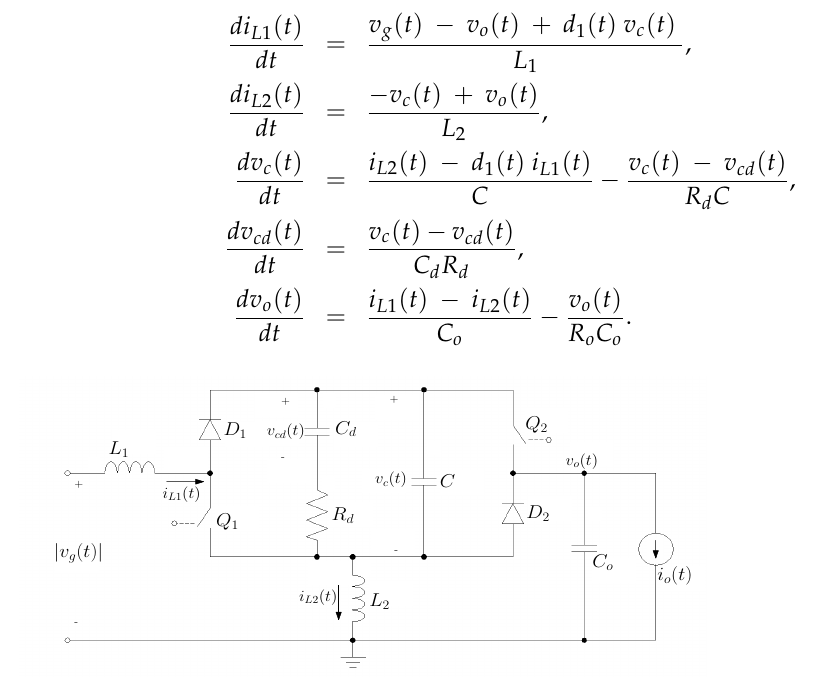
Figure 10. lBuck boost converter with RC snubber